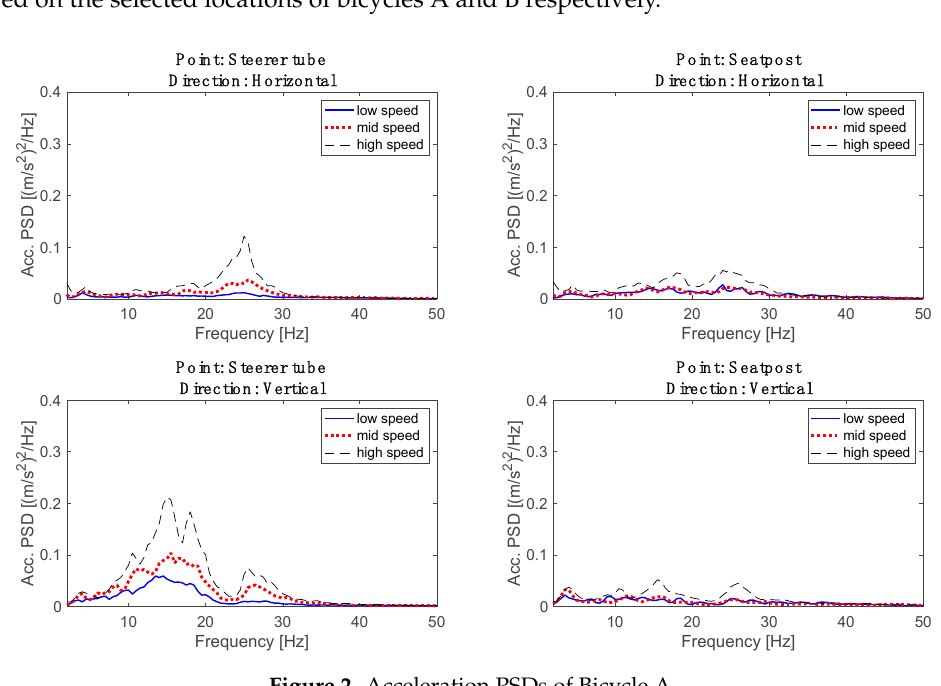
Figure 3. Acceleration PSDs of Bicycle B. 4. Harvester Tuning to the Bicycle The analysis in the frequency domain of road tests results clearly highlighted that for both bicycles most of vibration energy is contained into a low frequency band. The increase in bicycle speed increases the amplitude of vibrations but does not shift the peaks of the acceleration PSDs, which are related to the modes of vibration of the bicycle. Piezoelectric energy harvesters can operate in the 33 mode and in the 31 mode [22]. In the former mode the mechanical stress and the voltage act in the same direction, whereas in the latter mode the mechanical stress and the voltage act in perpendicular direction. Most of commercial harvesters are cantilever harvesters operating in the 31 mode, even if the electro-mechanical